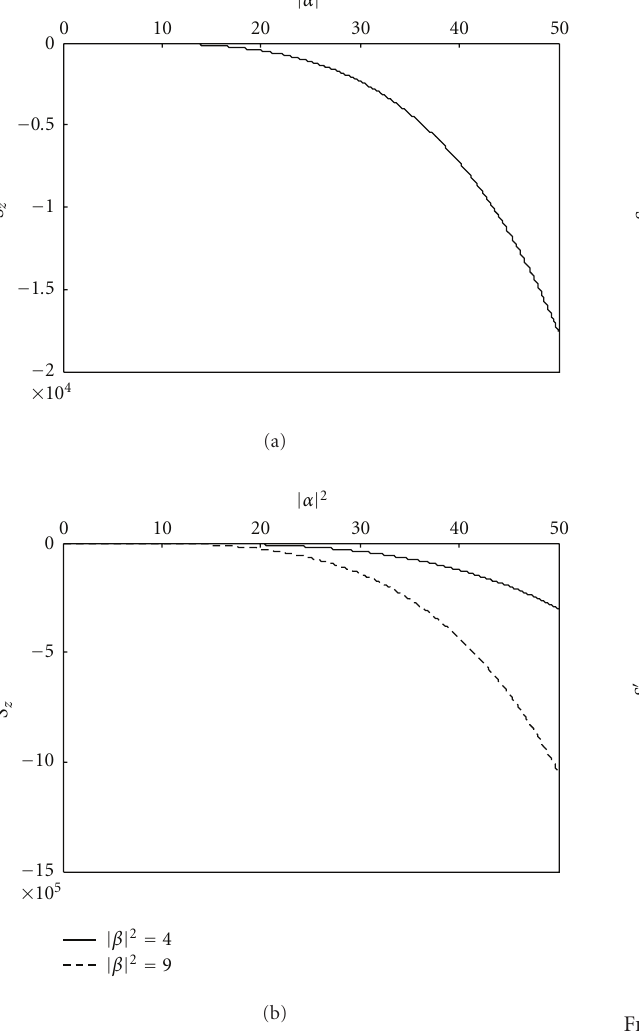
with | α | 2 and | β | 2 in f